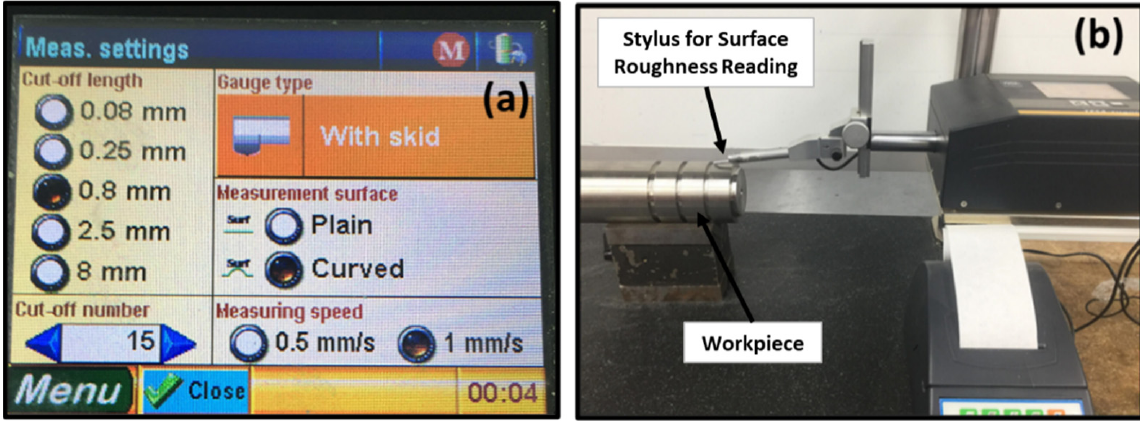
Figure 5. ( a ) Measuring setting parameters, ( b ) Test rig for measuring surface roughness.